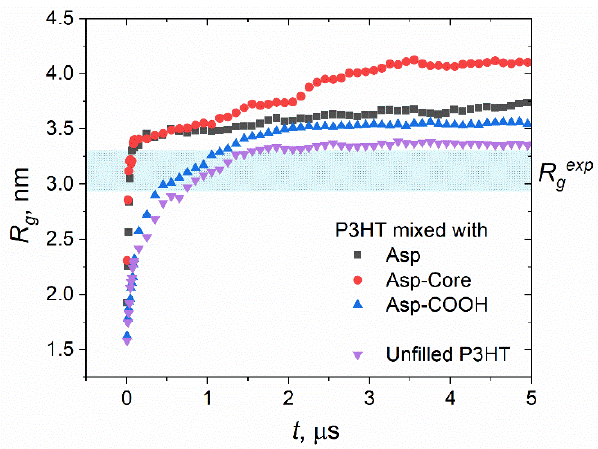
Figure 6. Radius of gyration R g of P3HT chains in the systems with asphaltenes and in the unfilled P3HT sample. The data on the unfilled P3HT sample were taken from our previous work [24]. Dotted blue region indicates the experimental R gexp values known from the literature [83,84].